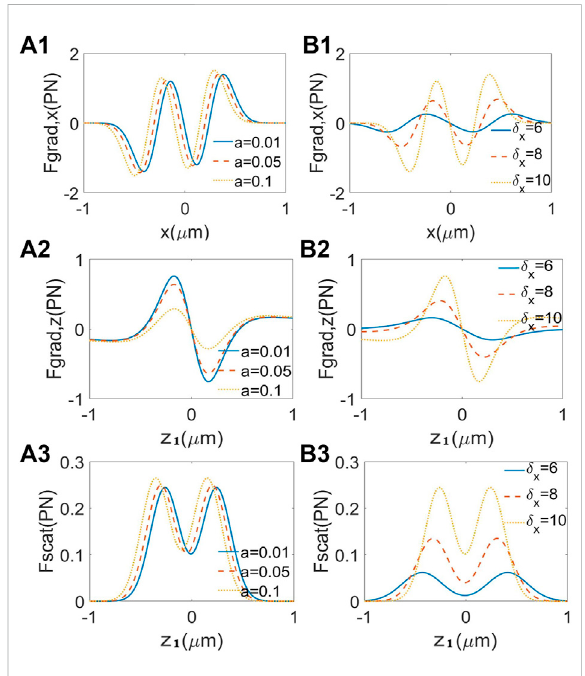
FIGURE 5 Effects of the shifting parameter a and the coherent length δ ontheradiationforcesforthelow-indexparticleatthefocalplane. (A1 – A3) σ x = 10 mm, σ y = 4 mm, δ x = 10 mm, δ y = 4 mm. (B1 – B3) a = 0:01 mm − 1